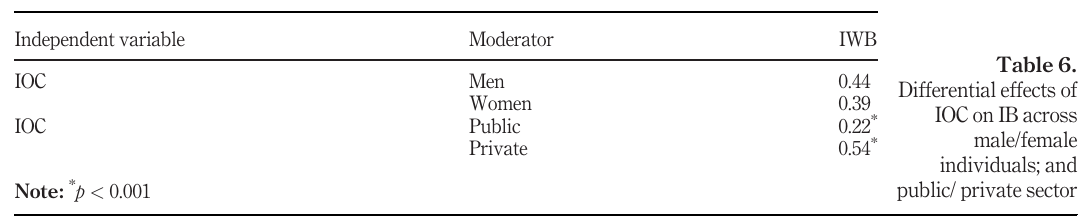
Table 6. Differential effects